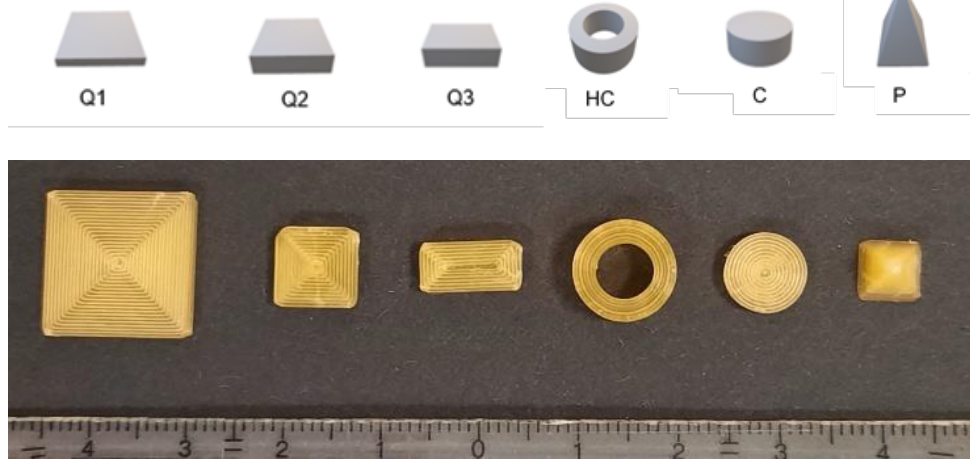
Figure 1. Designed geometries (from left to right): cube 1 (Q1), cube 2 (Q2), cube 3 (Q3), hollow cylinder (HC), cylinder (C) and pyramid (P). Upper image: CAD-Design, lower image: printed geometries of SA/V ratio 1.5 mm −1 .